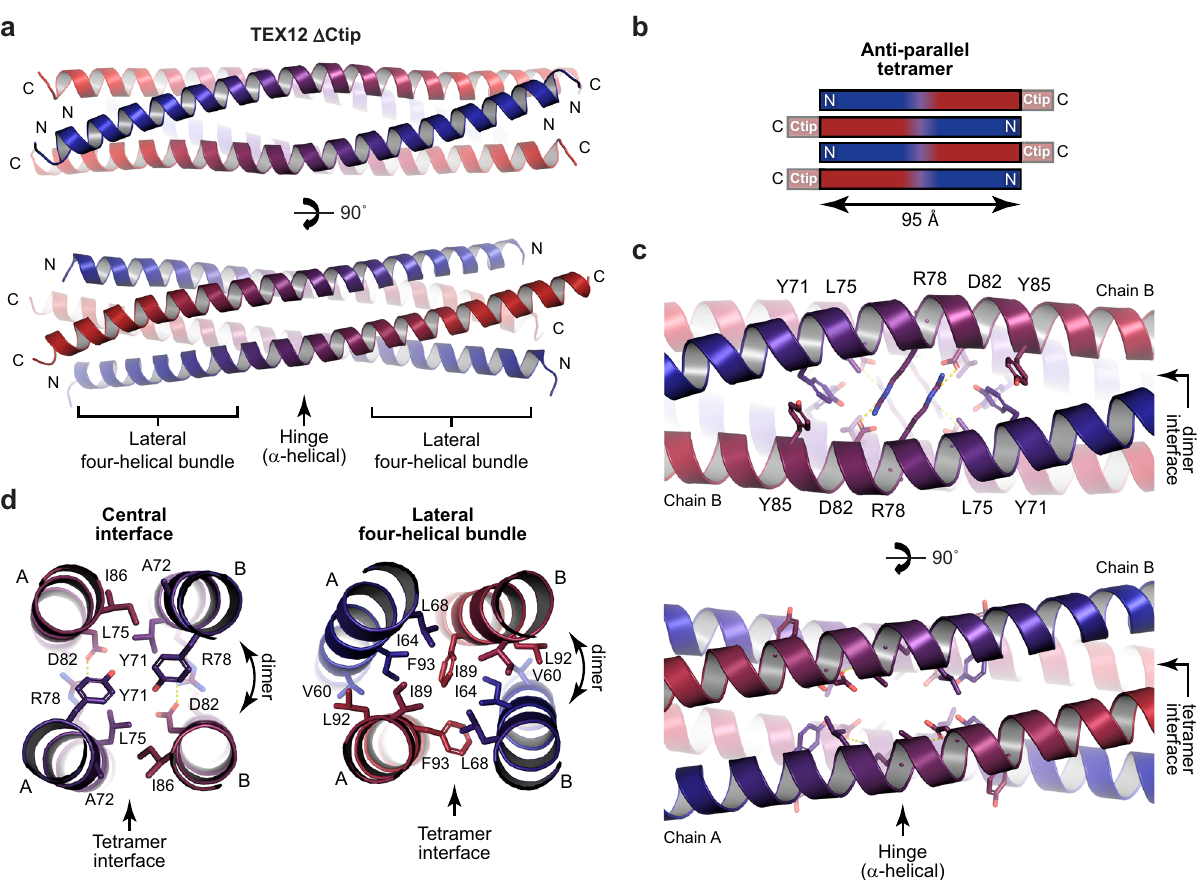
Fig. 3 Crystal structure of a TEX12 Δ Ctip tetramer. a Crystal structure of TEX12 Δ Ctip in a tetrameric conformation. The four TEX12 chains (coloured blue to red in an N- to C-terminal direction) are arranged in an anti-parallel con fi guration with a central ‘ hinge ’ fl anked by two lateral four-helical bundles. b Schematic of the TEX12 Δ Ctip structure highlighting the location of missing Ctip sequences in pairs on either side of the 95 Å core. c The hinge is de fi ned by salt-bridges between R78 and D82 amino-acids, and is supported by surrounding aromatic packing interactions of symmetry-related chains (dimer interface), and limited hydrophobic interactions between alternative chains A and B (tetramer interface). d The lateral four-helical bundles contain ‘ coiled- coil ’ -like interactions between symmetry-related chains (dimer interface), and hydrophobic and aromatic interactions between opposing dimers (tetramer